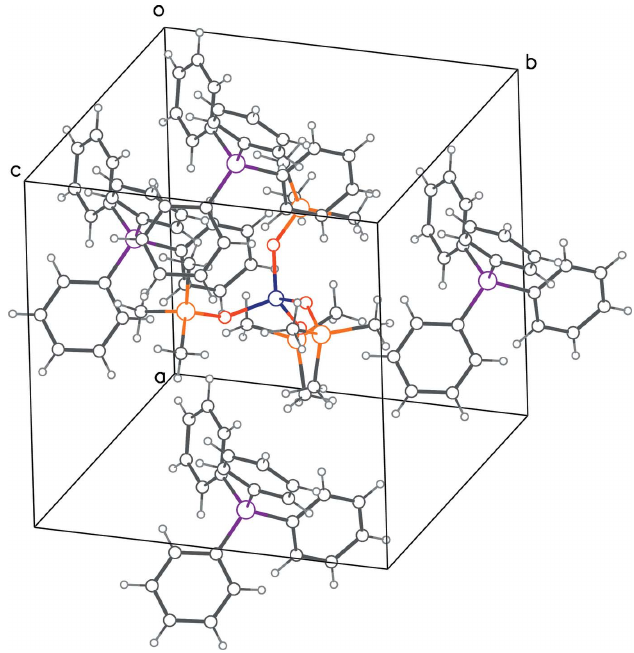
Figure 1 The molecular entities in the title salt showing the atom-numbering scheme. Displacement ellipsoids are drawn at the 50% probability level.